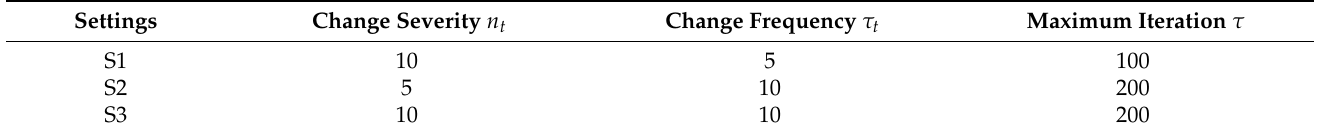
Table 1. The dynamic